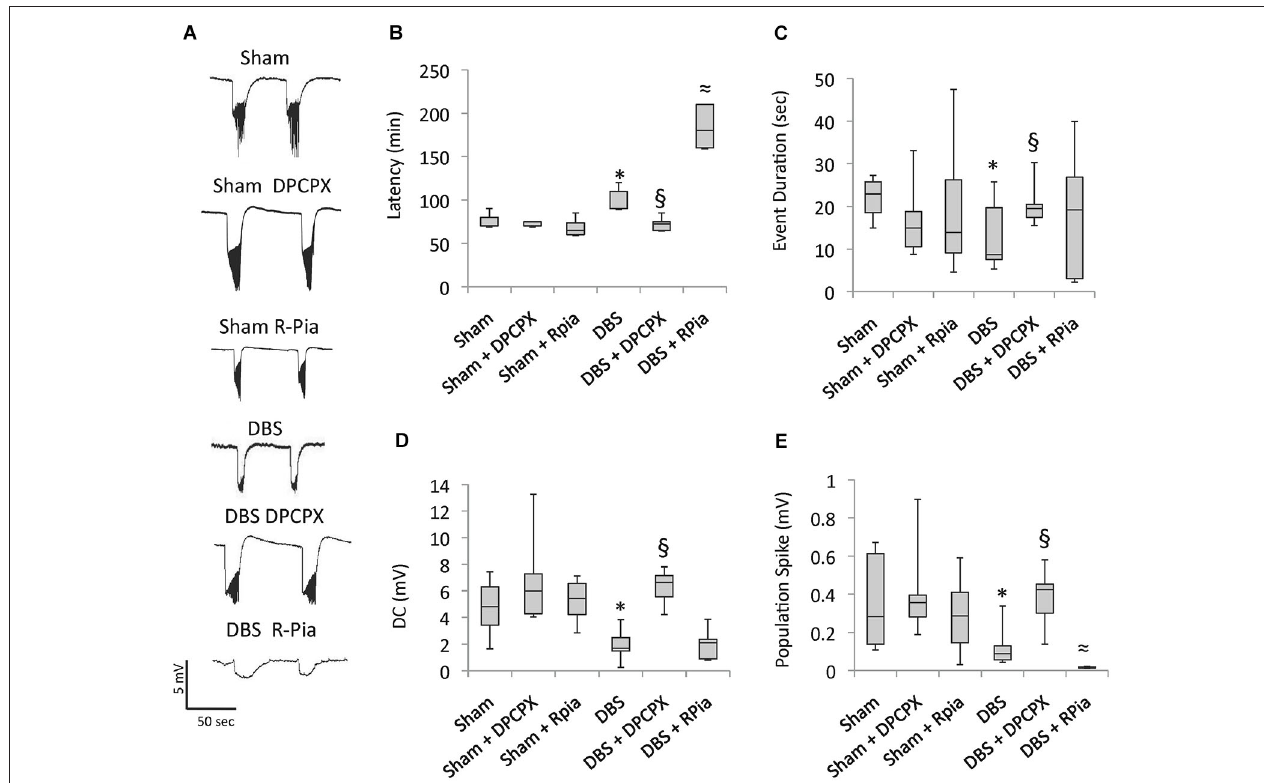
and smaller DC shifts, and a smaller spike amplitude as compared to slices from animals previously given no stimulation. The decrease in hippocampal excitability observed after AN stimulation was almost completely reversed in slices from animals previously given DBS + DPCPX. R-Pia potentiated the antiepileptic effects of DBS. The box shows median, quartile 1 and 3. The whiskers show minimal and maximal values. Significant differences between the groups ( p < 0.05; Kruskall Wallis followed by Mann Withney) are represented as follows: DBS vs. sham *; DBS vs. DBS + DPCPX §; and DBS vs. DBS + R-Pia ≈